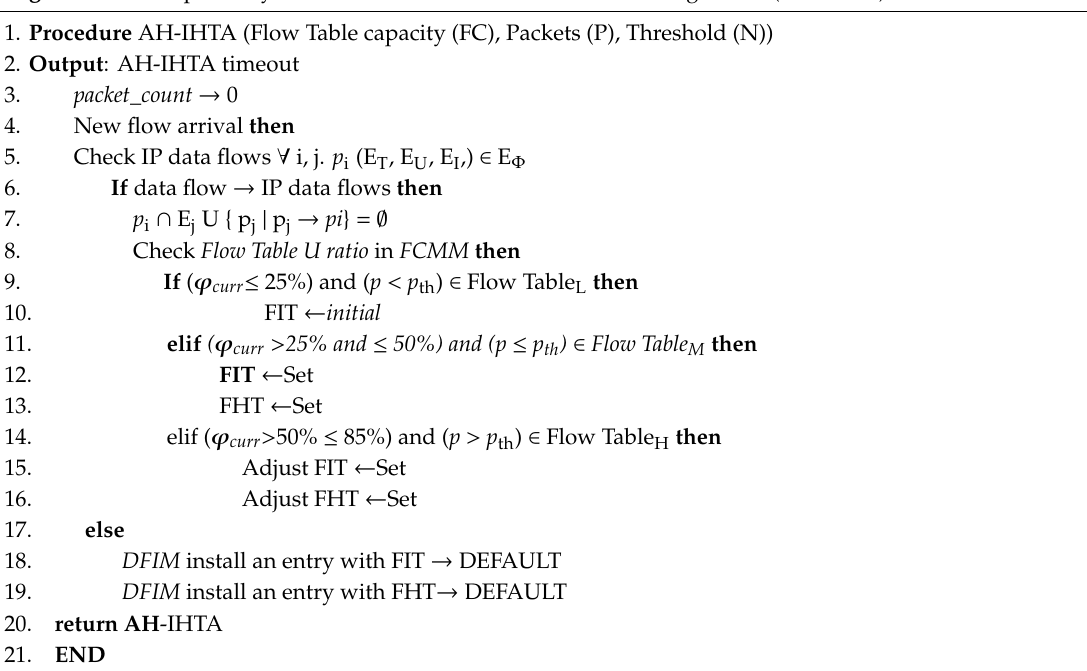
Algorithm 1 . Adaptive-Hybrid Idle and Hard Timeout Allocation Algorithm